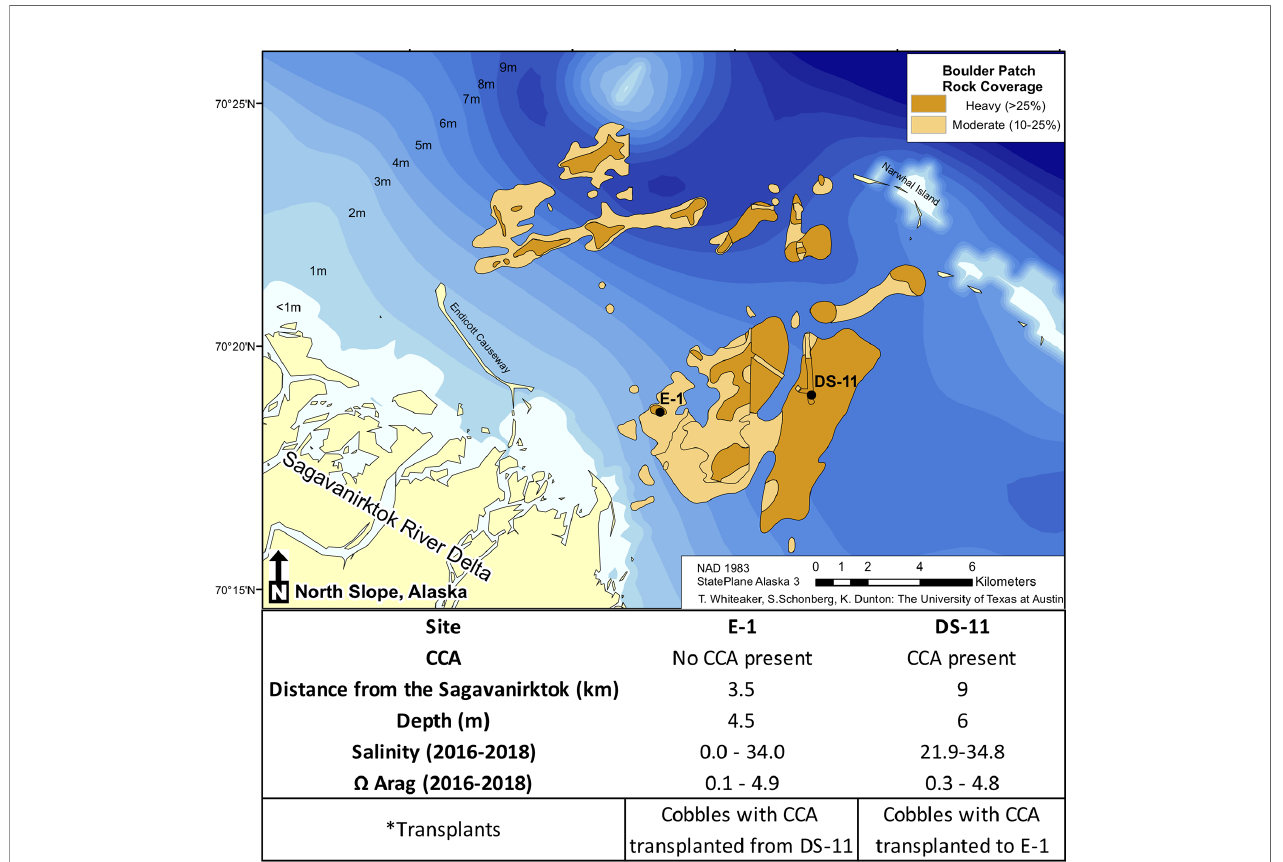
FIGURE 1 | The Boulder Patch kelp bed community in Stefansson Sound, Alaska (adapted from Bonsell and Dunton, 2018 showing rock cover, site distances (km) from the Sagavanirktok River (Sag), and ranges of salinity and W Arag (Muth et al.,